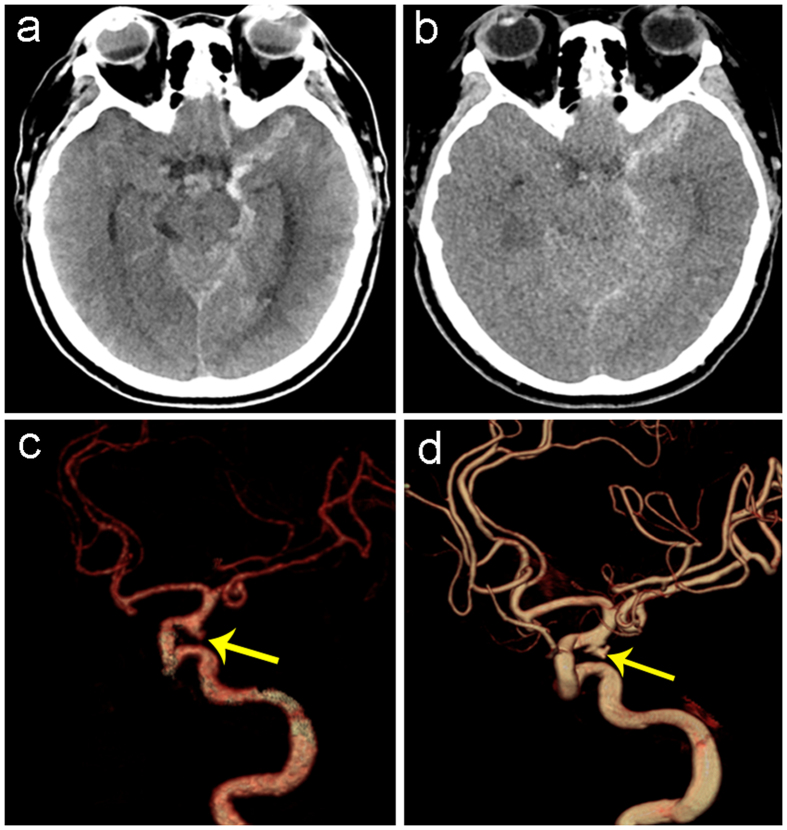
A 59-year-old women with spontaneous subarachnoid hemorrhage caused by ruptured aneurysm in left posterior communicating artery.(a) True non-enhanced CT image and (b) virtual non-enhanced CT image show subarachnoid hemorrhage, (c) volume-rendered dual-energy CTA image shows a true-positive aneurysm in the left posterior communicating artery (yellow arrow), which was confirmed by 3D-DSA (d).